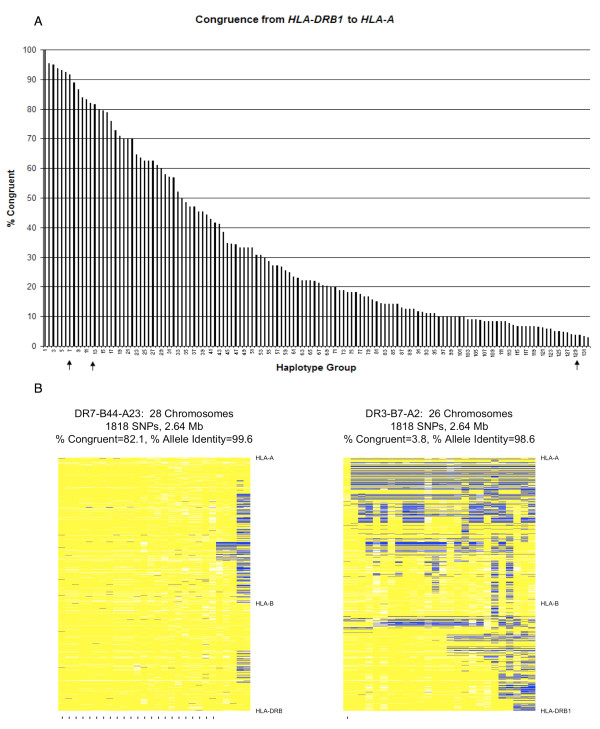
Congruence is widespread across the MHC and is not limited to the DR3-B8A1 haplotype. A: Percent congruence of 132 extended DQ-DR-B-A haplotype groups from HLA-DRB1 to HLA-A. Plotted is the percent of chromosomes (both cases and controls) within each HLA haplotype group that meet the rules for congruence from HLA-DRB1 to HLA-A. The number of chromosomes in each group ranged from 8 to 747 (mean = 34, median = 17), and specific details for each haplotype group are given in Additional file 4: Table S1. Arrows identify haplotype groups that will be discussed further in the paper (number = DR.B.A: 7 = 3.8.1, 12 = 7.44.23, 129 = 3.7.2). B: Examples of congruence within two haplotype groups. In these two images, each column represents one founder chromosome (represented by 1,818 SNPs across 2.64 Mb ranging from HLA-DRB1 to HLA-A on chromosome 6) with the specified HLA alleles (e.g., DR7, B44 and A23). Each row illustrates data for one SNP. Yellow represents alleles that match the consensus sequence, whereas blue represents alleles that do not match the consensus. White denotes missing or unphased alleles. Congruent chromosomes are indicated by a tick mark at the bottom of the image. The DR7-B44-A23 haplotype group exhibits extreme congruence from HLA-DRB1 to HLA-A, seen by the high frequency of chromosomes that are congruent for the entire region (yellow from HLA-DRB1 to HLA-A). In contrast, DR3-B7-A2 shows an example of a haplotype group in which only one of the chromosomes is congruent across the region. Because the consensus chromosome is derived from a set of chromosomes, it is not necessarily an exact match to any particular chromosome. Thus the one congruent chromosome in this haplotype group does not have 100% allele identity